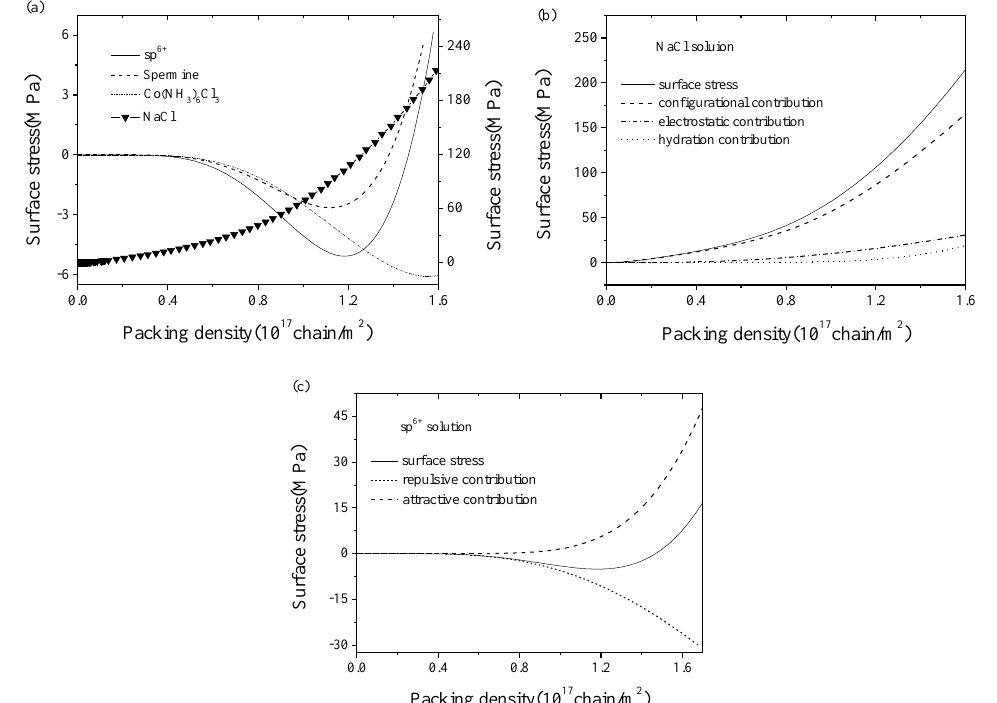
Figure 2. ( a ) Surface stress variation of dsDNA films with packing density in sp 6+ , spermine, Co(NH 3 ) 6 Cl 3 , and NaCl solutions. The left longitudinal axis is related to DNA in multivalent solutions and the right one is related to DNA in NaCl solution. By convention, the positive value represents the compressive stress while the negative value means the tensile one. ( b ) Contributions of electrostatic energy, hydration energy, and configurational entropy to the surface stress in NaCl solution. ( c ) Contributions of the repulsive and attractive parts of free energy to the surface stress in sp 6+ solution.